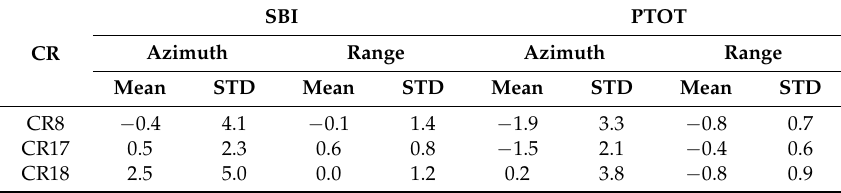
Figure 4. Comparison of displacement measurements at stable Corner reflectors (CRs) by Split-bandwidth interferometry (SBI) and point-like targets offset tracking (PTOT) in azimuth and range directions. Table 2. Basic statistics of stable CRs outside Shuping landslide (unit: cm).